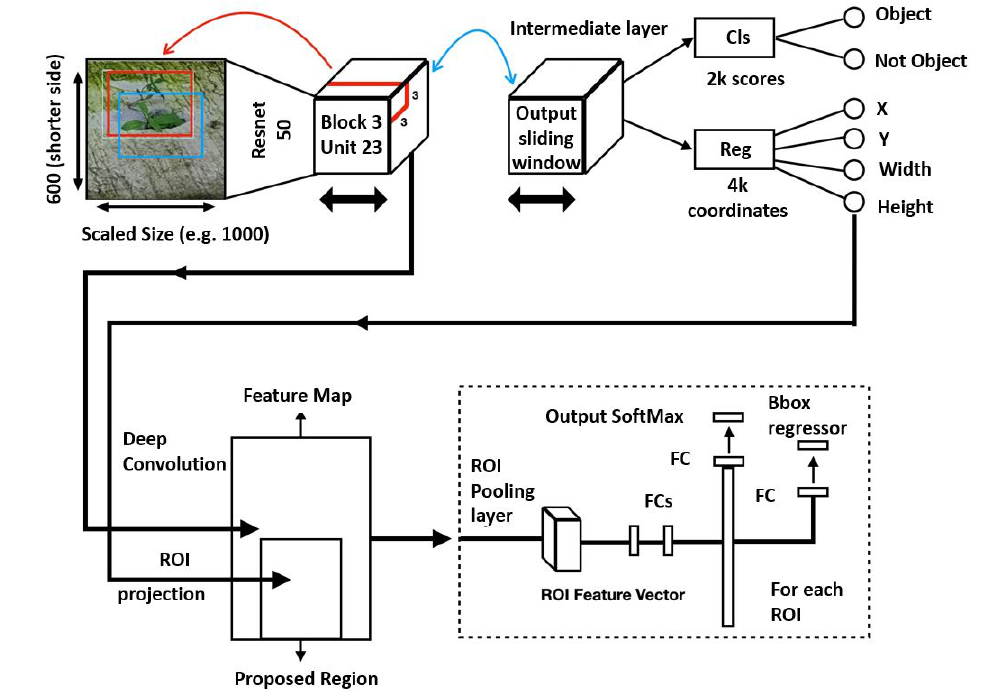
Figure 8. Functional block diagram of the Faster RCNN framework.